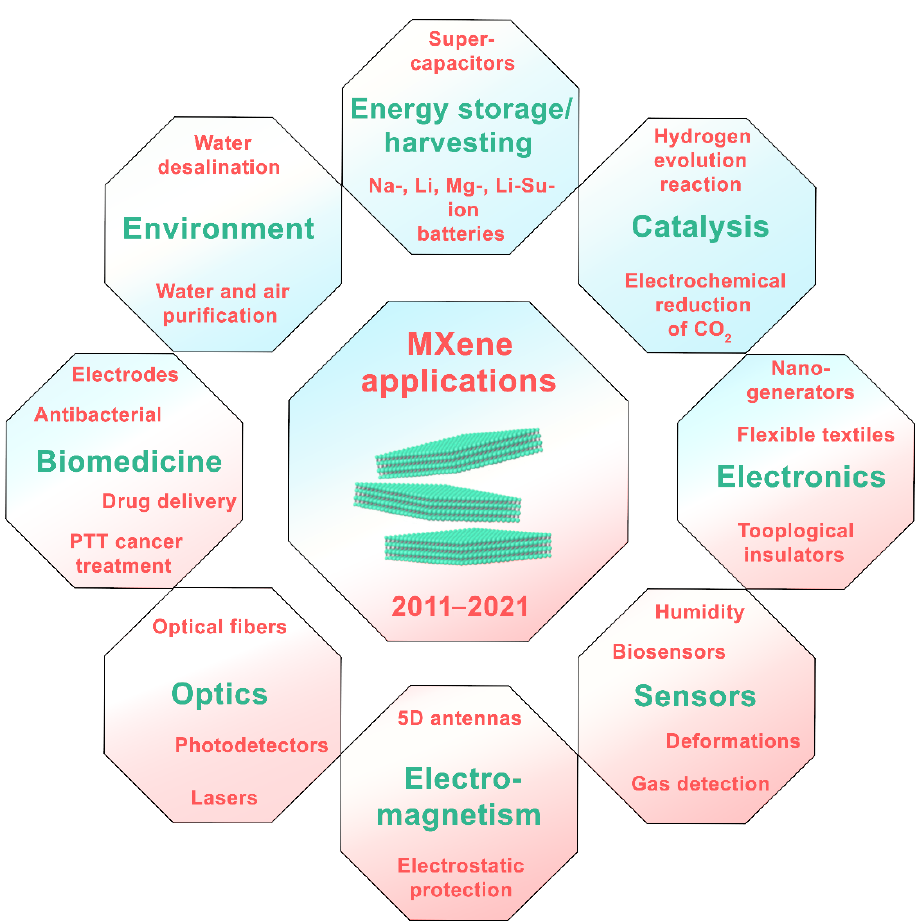
Figure 25. Possible applications of two-dimensional MXene in various